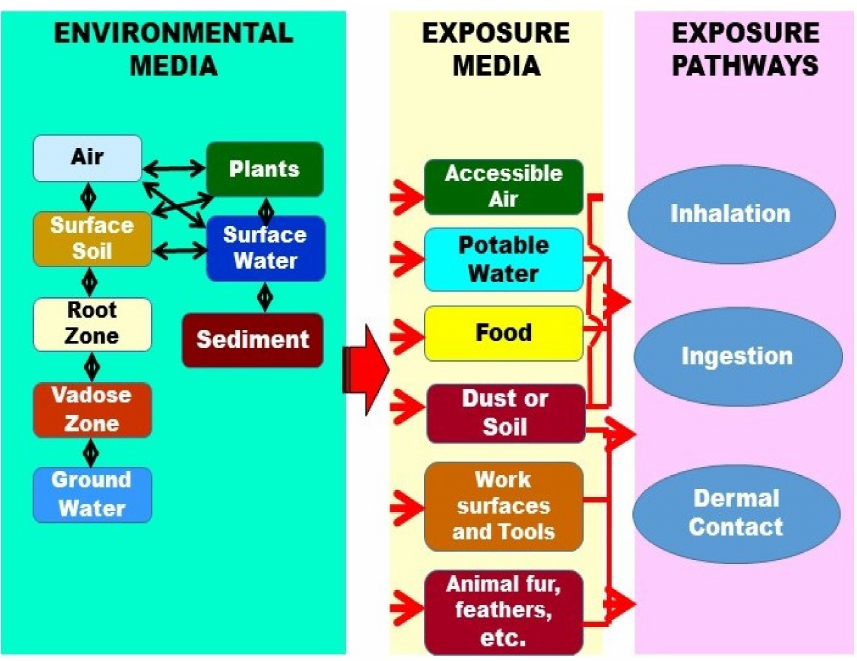
Figure 2. Routes of exposure to pesticides (by